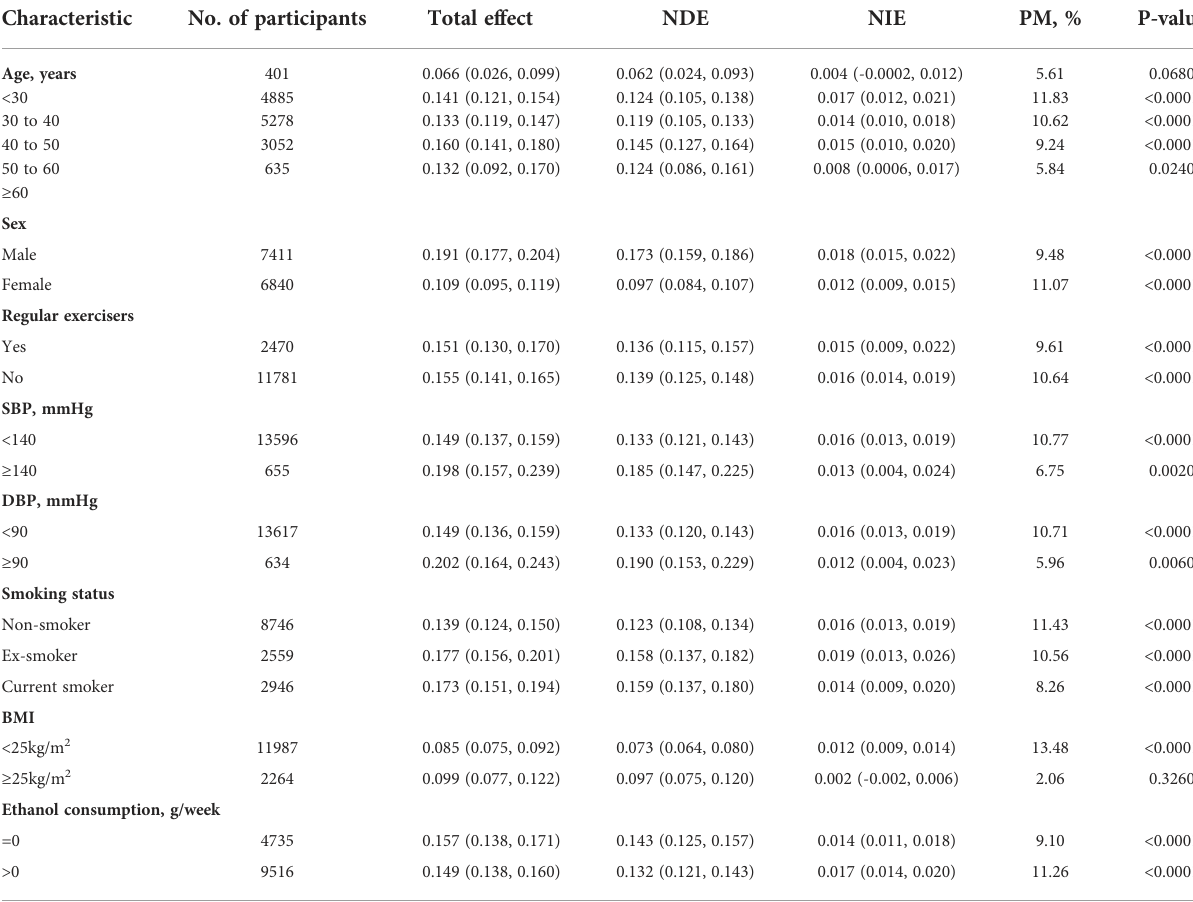
TABLE 8 Mediation analysis of the association between WHtR and NAFLD mediated by TG in prespeci fi ed and exploratory subgroups.